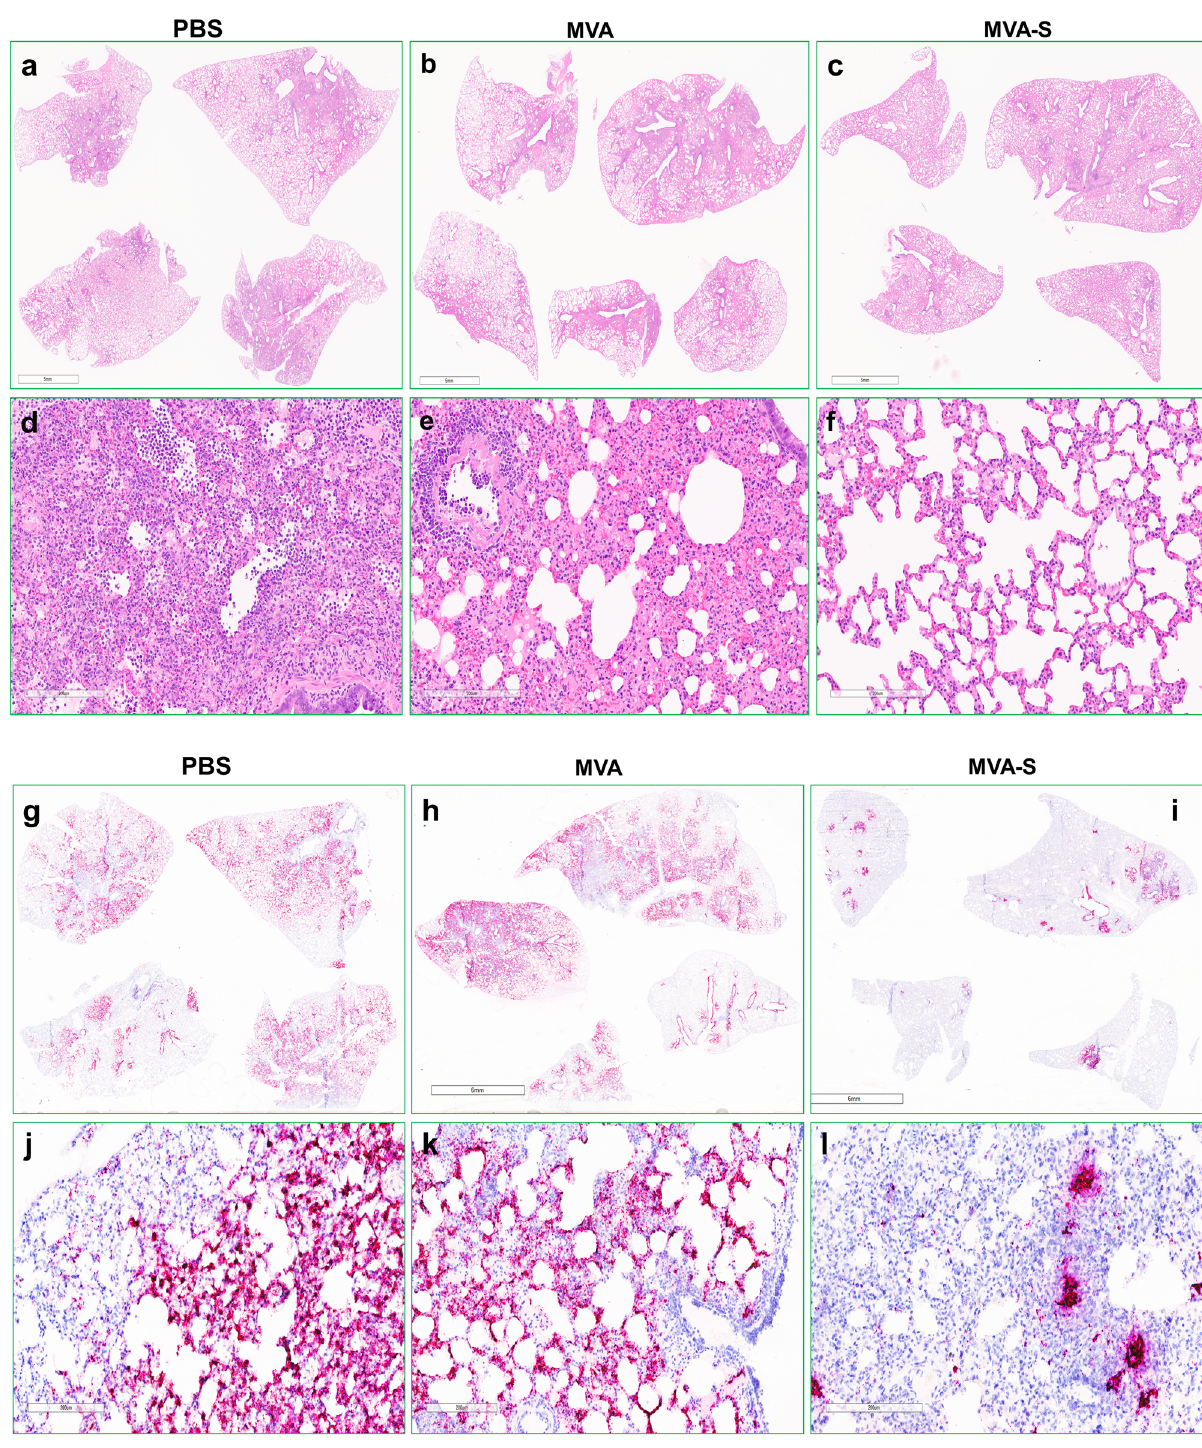
Fig. 5 Histopathology and detection of SARS-CoV-2 RNA in the lungs of challenged Syrian hamsters. Lung tissues were harvested at 4 days post SARS-CoV-2 challenge from hamsters that were previously vaccinated with PBS, MVA, or MVA-S. Formalin- fi xed, paraf fi n-embedded lung tissues were stained either by hematoxylin and eosin (H&E, a – f ) or by a SARS-CoV-2 RNAscope probe ( g – l ). Pathology scores were determined by a licensed pathologist who viewed 3 – 4 sections in each study group in a blinded fashion. Panels a – c and g – i are images of all lobes from a representative hamster in each group. Panels d – f and j – l are close-up images from a representative area of panels a – c and g – i , respectively. In panels g – l , the blue color indicates nucleus staining and the red/pink color represents SARS-CoV-2 spike positive-sense (genomic) RNA. The scale bar represents 5 mm ( a – c ); 6 mm ( g – i ); and for the rest ( d – f , j – l ) the bar represents 200 μ